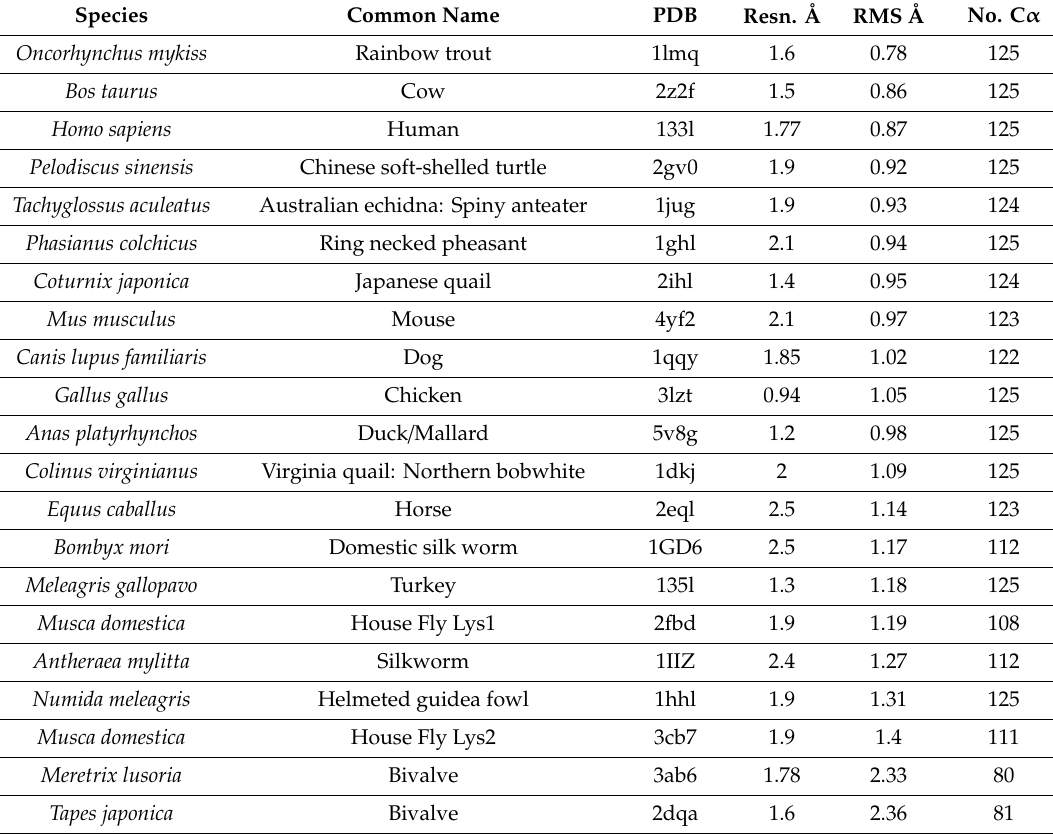
Table 2. The structures of GH22 lysozymes in the PDB and their similarity to Oh